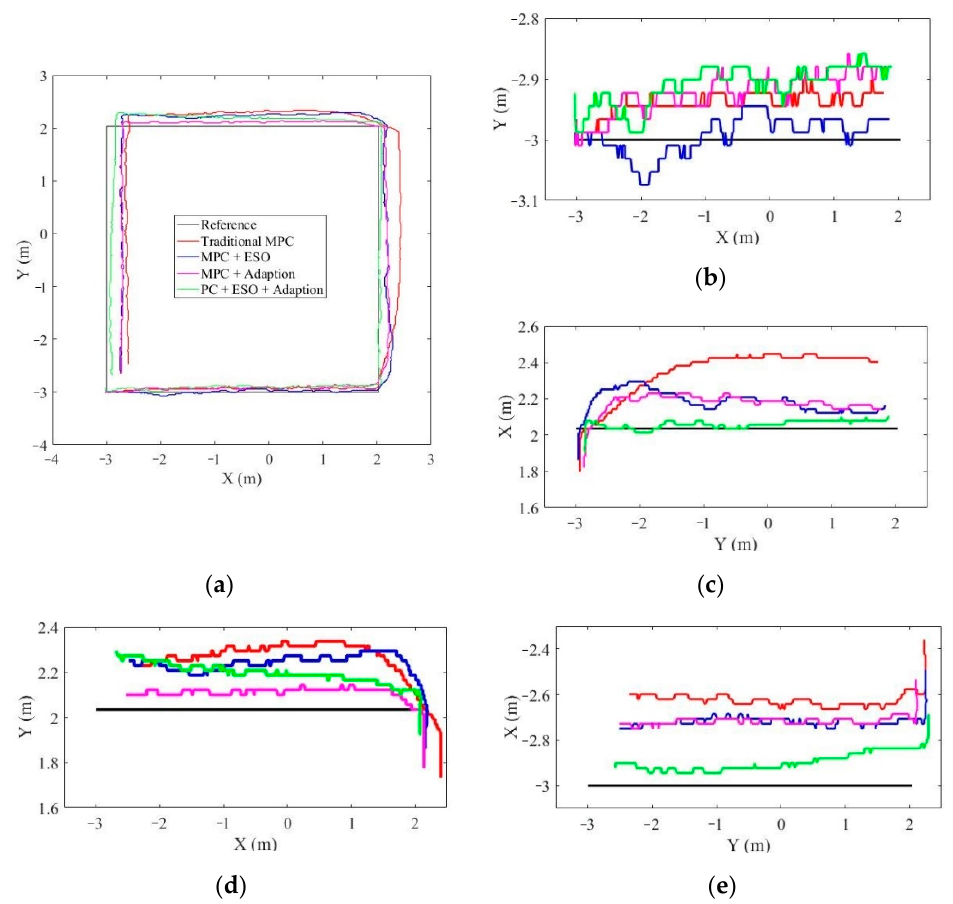
Figure 15. The trajectory of the robot when the disturbance velocities were u = 0.2 m/s and v = 0.2 m/s. ( a ) The diagram of the overall trajectory; ( b ) The trajectory from − 3 m to 2 m in the X direction; ( c ) The trajectory from − 3 m to 2 m in the Y direction; ( d ) The trajectory from 2 m to − 3 m in the X direction; ( e ) The trajectory from 2 m to − 3 m in the Y direction.